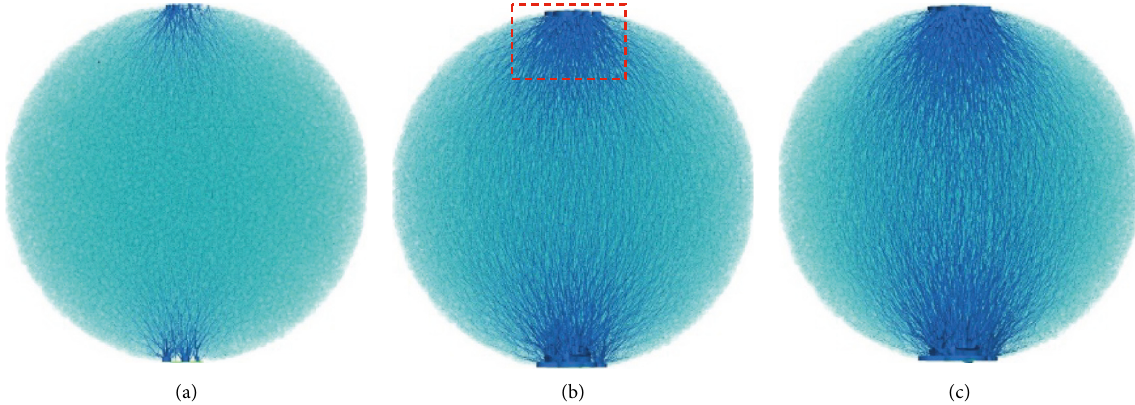
Figure 11: Distribution diagram of the compression chain: (a) 0.662kN, (b) 4.089kN, and (c) breaking moment.